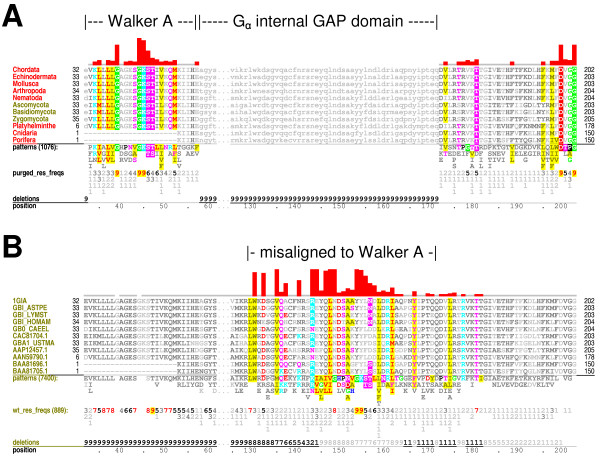
CHAIN analysis of P loop GTPase-specific constraints acting on the Giα subunit. The displayed sequences are representatives of the Giα family of Gα proteins from distinct phyla. The foreground sequence set, which also includes P loop GTPases outside of the Giα family, are represented by the conserved residue patterns below the alignments. The number specified after the word 'pattern' gives the actual number of aligned sequences. (A) Motif-based contrast hierarchical alignment. Phyla are indicated in the leftmost column. Note that a purged foreground set [5] was used for the motif-based alignment in (A) and is thus smaller than the full set used by PSI-BLAST in (B). PSI-BLAST compensates for sequence redundancy by down weighting sequences [35] rather than by purging. The corresponding residue frequencies are given in integer tenths below the conserved patterns. For example, a '7' in integer tenths indicates that the corresponding residue directly above it occurs in 70–80% of the sequences. Deletion frequencies are similarly given in integer tenths (black; range 10–100%) or hundredths (gray; range 1–9%) as indicated. Histograms above the alignments display the strengths of the selective constraints acting at each position; aligned residues subject to the strongest constraints are highlighted for emphasis. For a complete description of CHAIN analysis alignments see [3]. (B) PSI-BLAST generated contrast hierarchical alignment. Sequence identifiers are indicated in the leftmost column. Note that, unlike the motif-based alignment in (A), PSI-BLAST misaligns the foreground set's Walker A region (represented by the patterns below the displayed alignment). In order to accentuate this alignment error, the background alignment in (B) consists of the foreground alignment in (A).